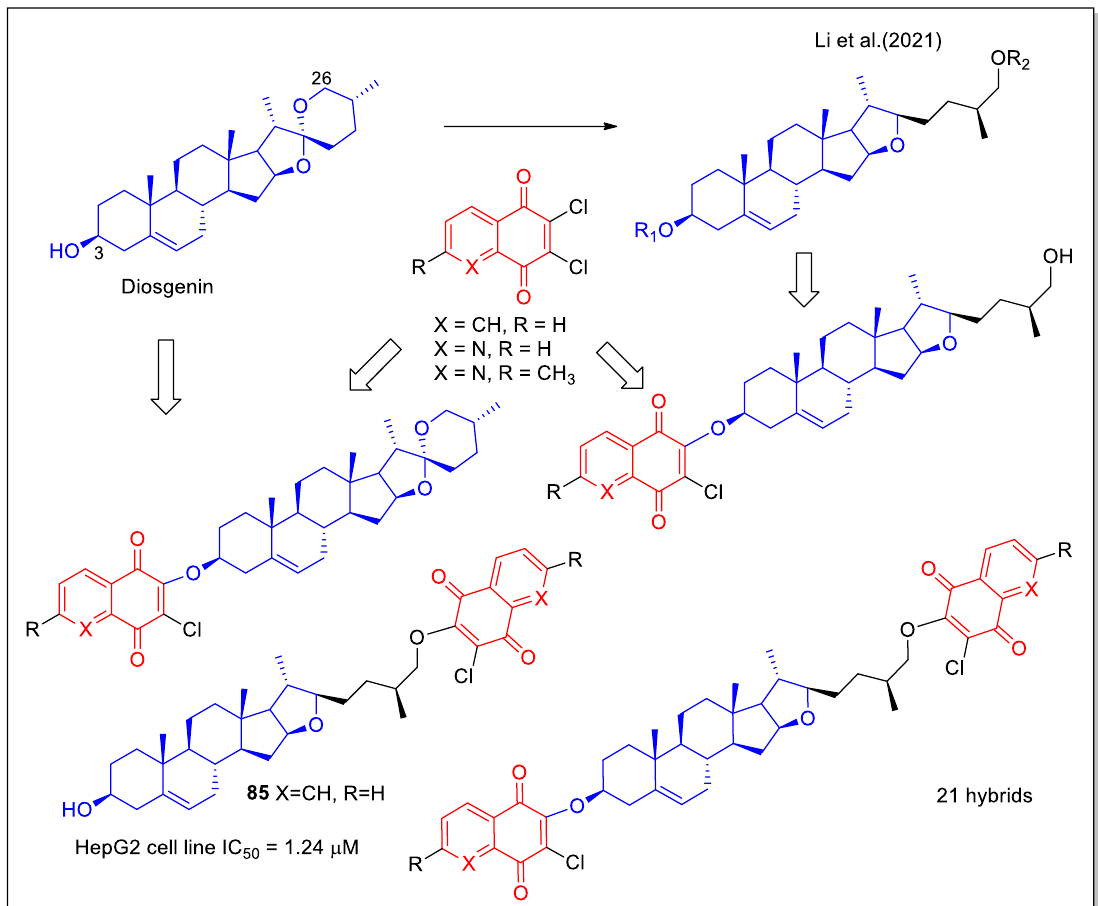
Figure 31. 1,4-Naphthoquinone or quinoline 5,8-dione hybrids with diosgenin as reported by Li et al. [72].